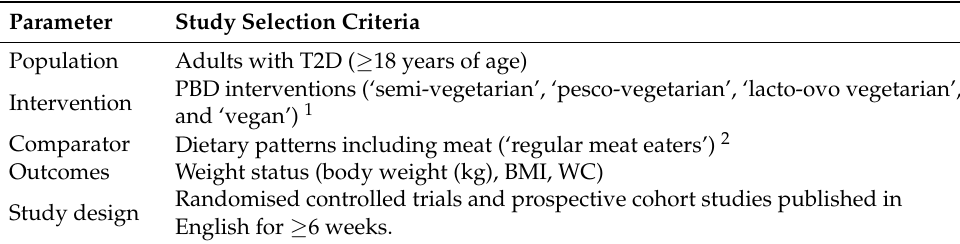
Table 1. PICOS criteria for inclusion of